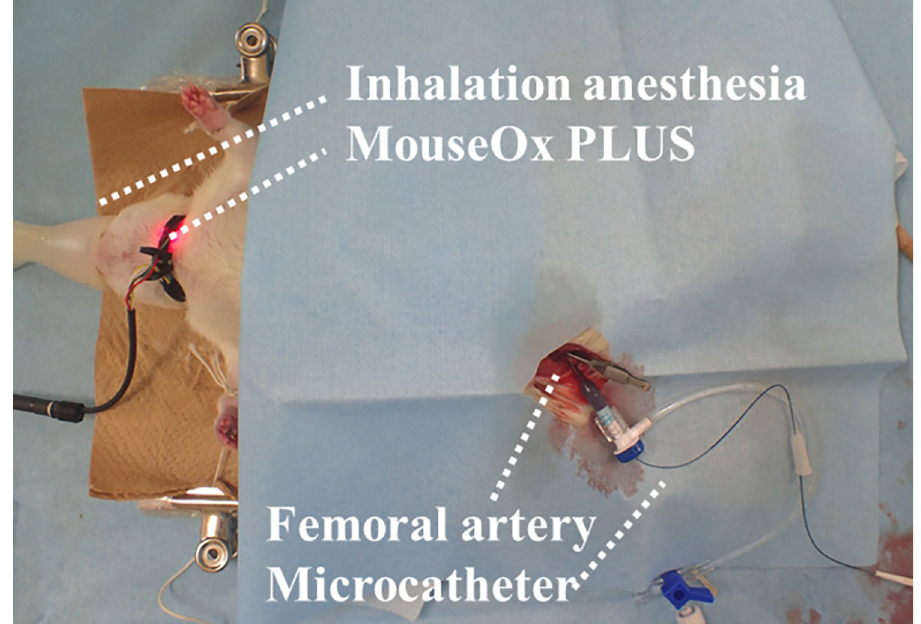
Fig 2. Representative rat experiment. Rats were anesthetized with 1.5% isoflurane in air. Vital signs including peripheral oxygen saturation (%), heart rate (beats/min), and respiratory rate (breaths/min) were monitored by MouseOx PLUS (Starr Life Sciences Corp., Oakmont, PA, USA). A microcatheter was inserted through the femoral artery.